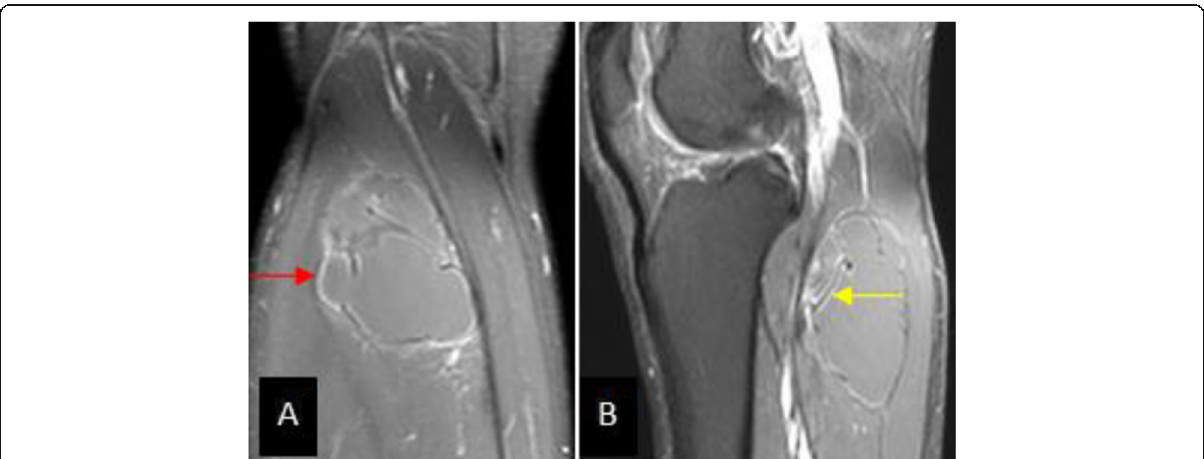
Fig. 4 Thirty-year-old male with lymphangioma in the proximal leg along the posterior aspect. Findings: coronal ( a ) and sagittal ( b ) post-contrast fat saturation images showing enhancing capsule (red arrow) and internal septae (yellow arrow). No enhancing mural components/papillary projections are seen within. No enhancement is seen in the adjacent muscles. Technique: Philips Insta 1.5-T MRI — fat-saturated, post-Gd T1WI: TR